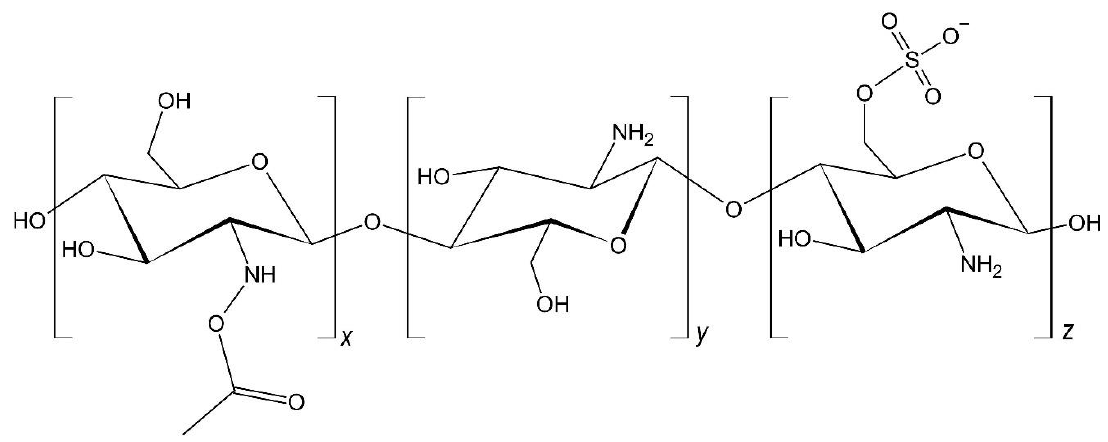
Figure 1. Structures of the ChS monomer units.